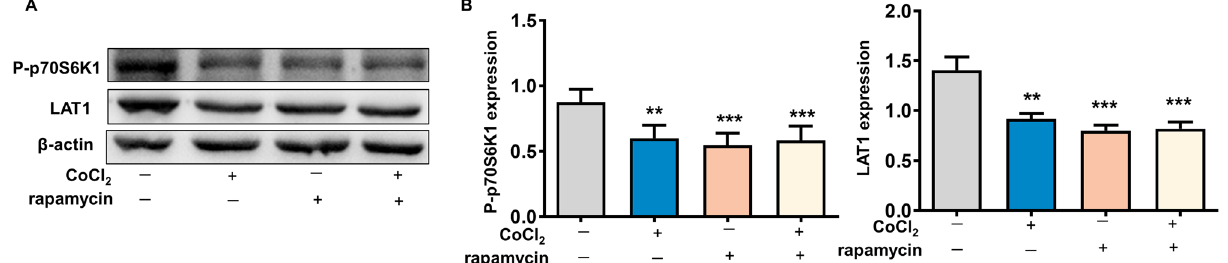
Figure 5. Effects of mTOR inhibitor on LAT1 expression in placental trophoblasts. ( A ) Protein expression of LAT1 in HTR-8/SVneo trophoblast cells treated with mTOR inhibitor rapamycin in the presence or absence of CoCl 2 . Rapamycin markedly inhibit P-p70S6K1 expression in trophoblast cells. The LAT1 expression was significantly downregulated in cells treated with rapamycin. ( B ) The bar graphs show relative expression of LAT1 after normalization by β-actin in each sample from six independent experiments. **P < 0.01, ***P < 0.001, treated vs